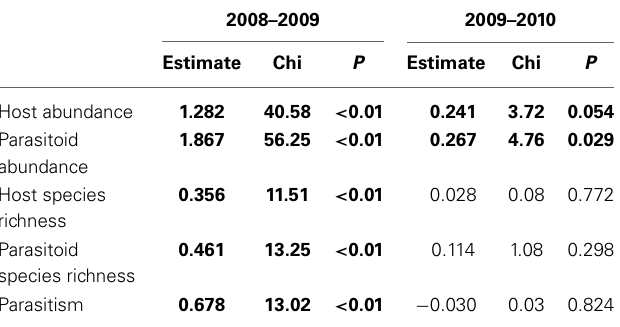
Table 3 | Results of pairwise differences between years (GLMM with Poisson or binomial distribution and site and individual observation as random